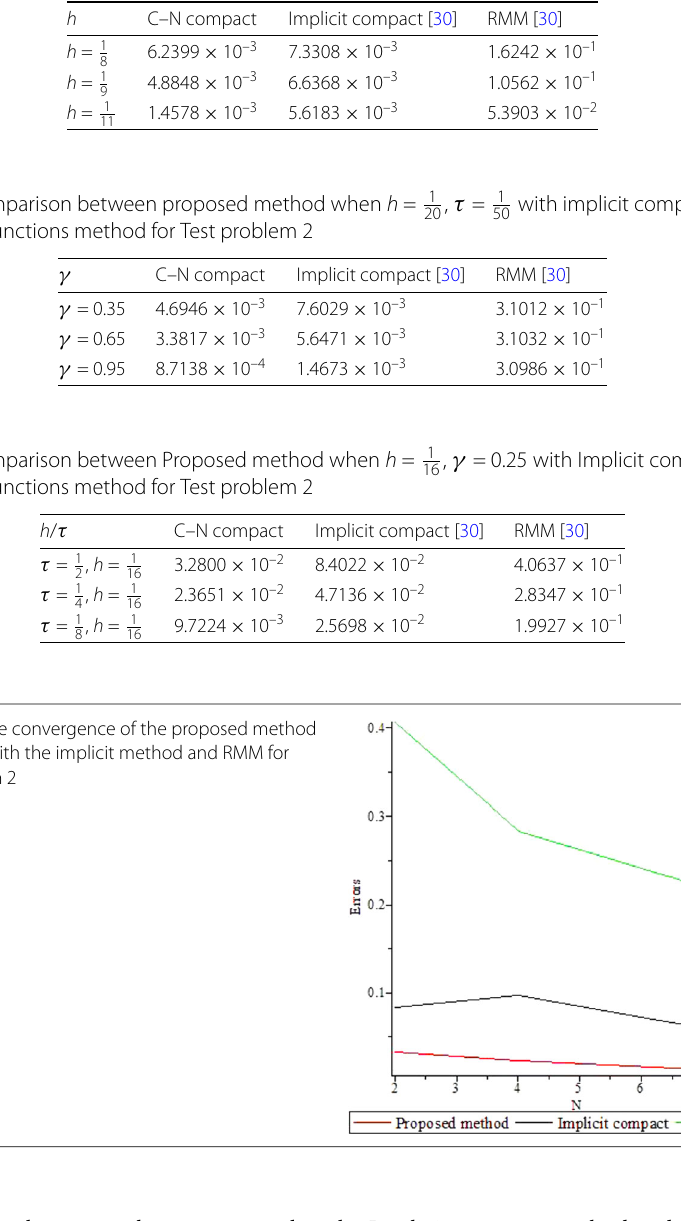
Table 5 Comparison between proposed method when τ = 1 radial basis functions method for Test problem 2